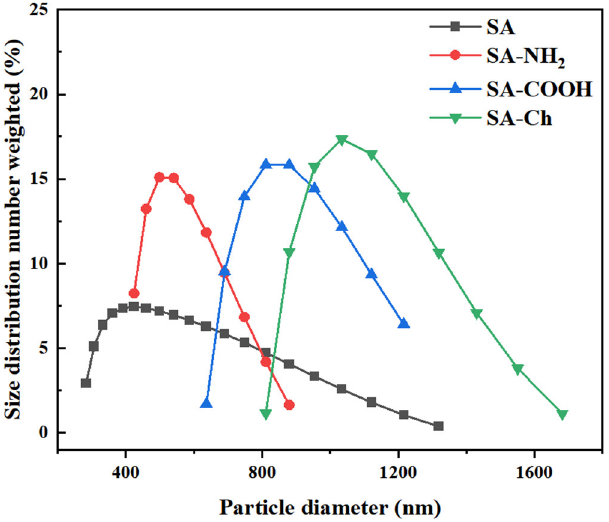
2 ( b ), SA-COOH ( c ), and SA-Ch ( d ).